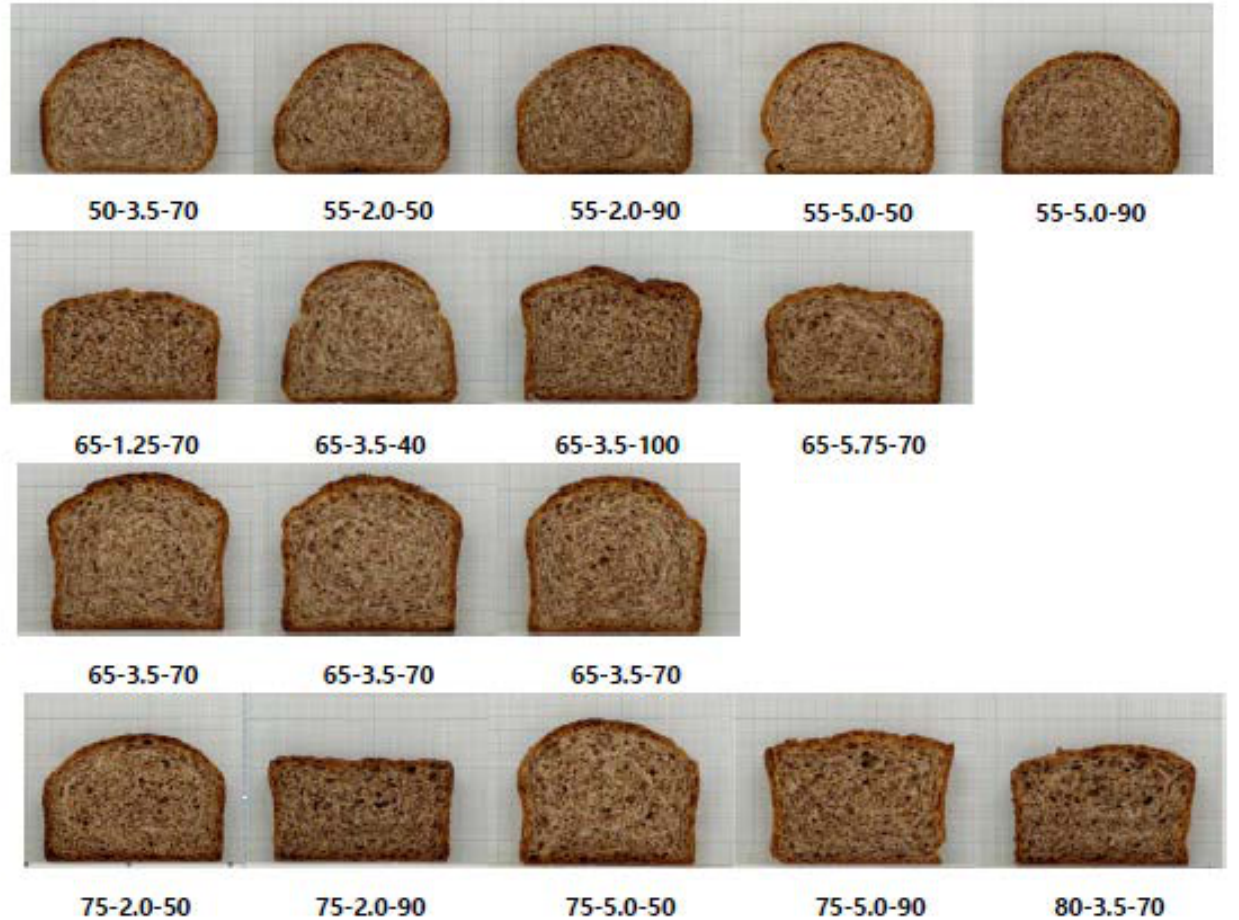
Figure 5. Cross-sections of bread prepared with flour–bran blend at 30% bran at different water amounts, mixing times and fermentation times based on response surface methodology: samples are indicated in terms of “water-mixing time– fermentation